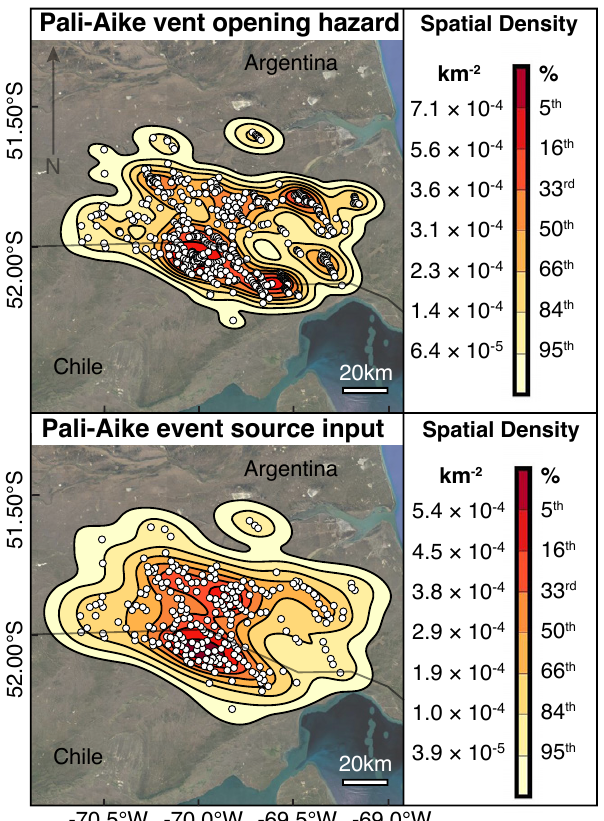
Figure 13: Vent opening hazard map and event eruptive source parameter map for Pali-Aike. Map background data: Google, CNES/Airbus, Maxar